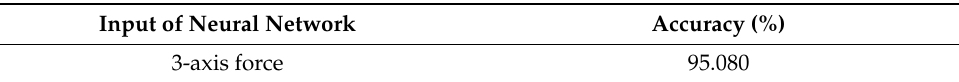
Table 2. Accuracy results of texture classification of a single 3-axis force sensor built into the robot gripper.